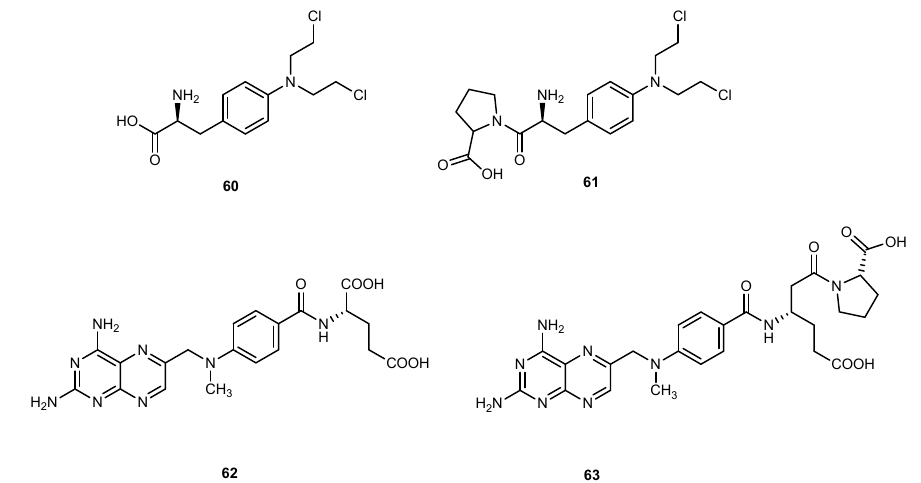
Figure 27. Chemical structures of melphalan ( 60 ) and methotrexate ( 62 ) and its proline conjugates ( 61 and 63 ).